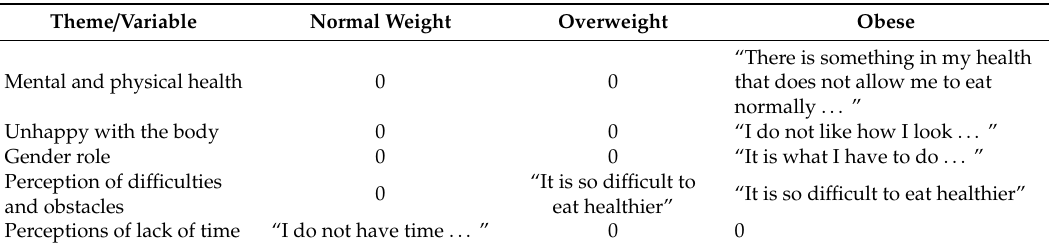
Table 5. Other factors that influence women’s eating behaviors by weight